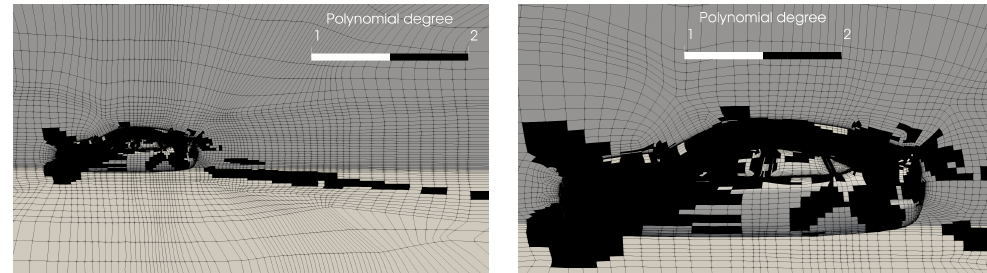
Figure 8. Simplified DrivAer model—Polynomial degree distribution P n of the solution in the low-Reynolds number case far from the model ( left ) and near to the model ( right